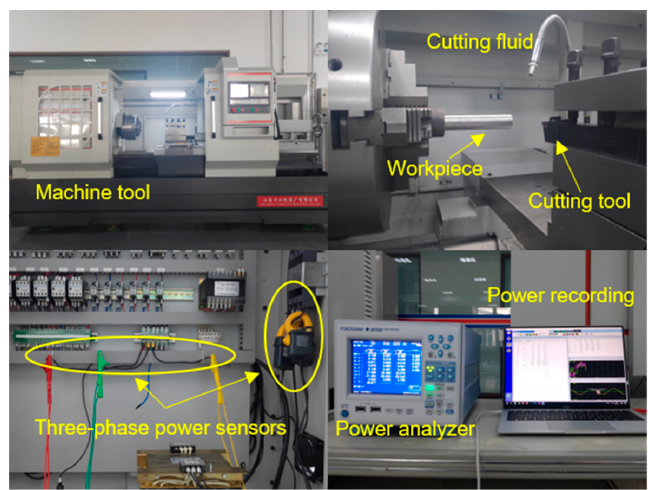
Figure 2. Experimental processing and measuring equipment.